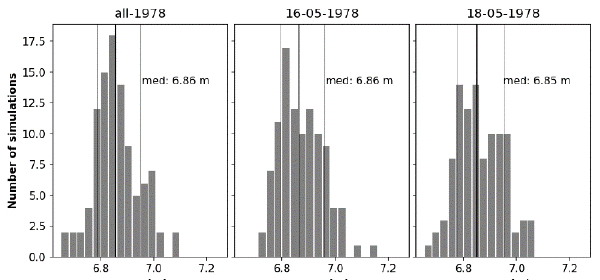
Figure 5. Residual error of GCP (in m) resulting from 100 bootstrap samples alignment and optimization. All simulations